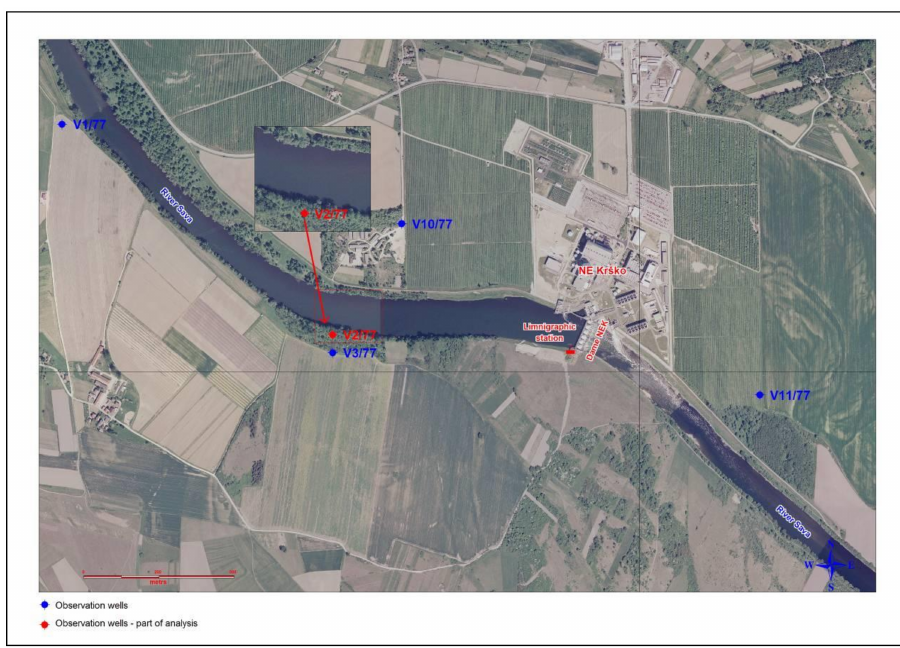
Figure 1. Layout of monitoring sites by the Sava